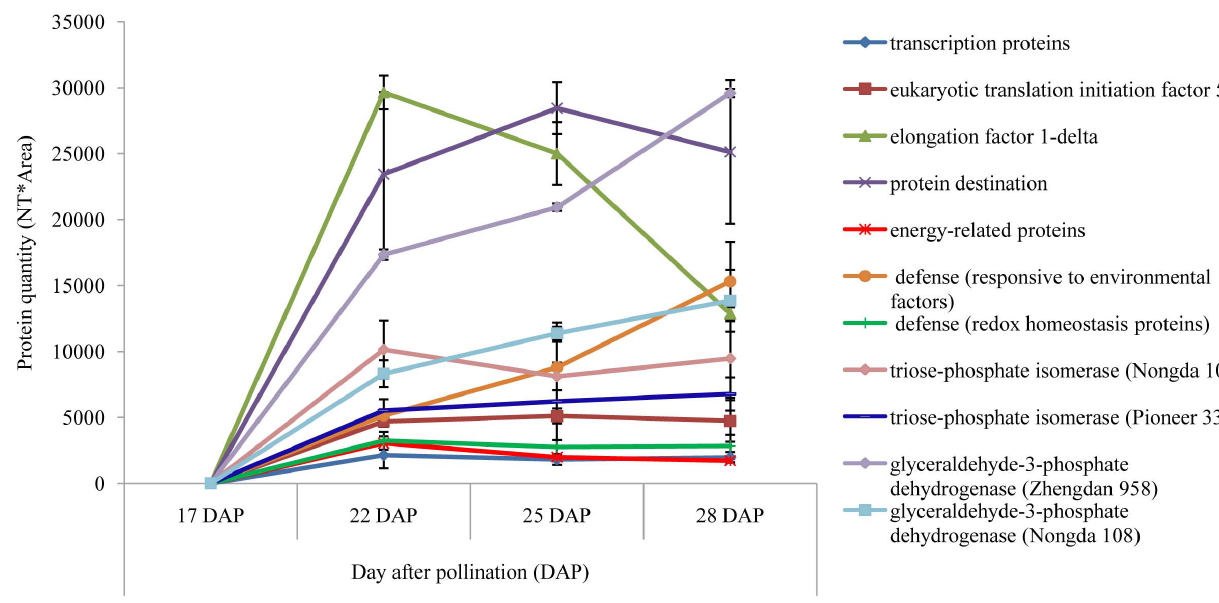
Figure 4. Plot figure for represented differentially expressed protein spots in endosperm with relative intensities.